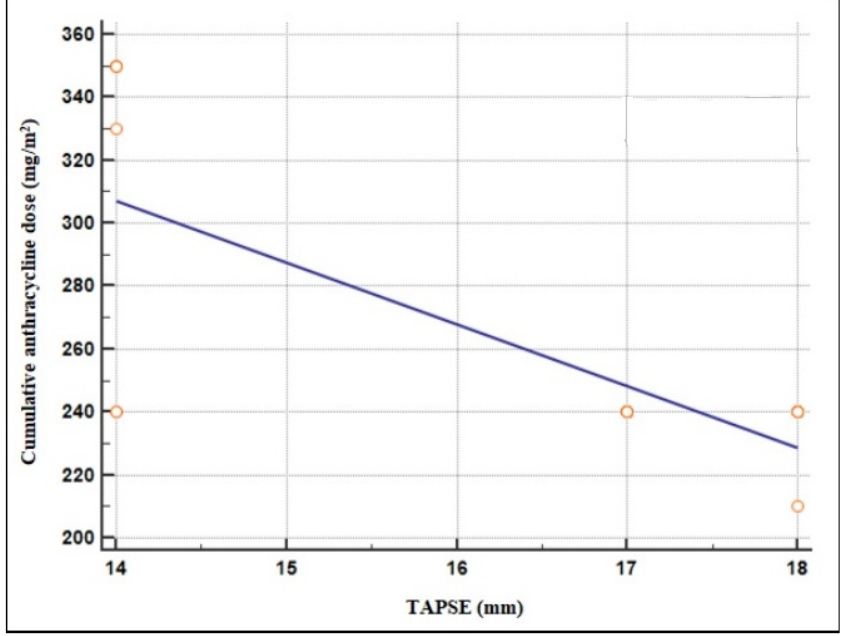
Figure 2. Inverse relationship between cumulative anthracycline dose (mg/m 2 ) and the systolic function of the right ventricle.